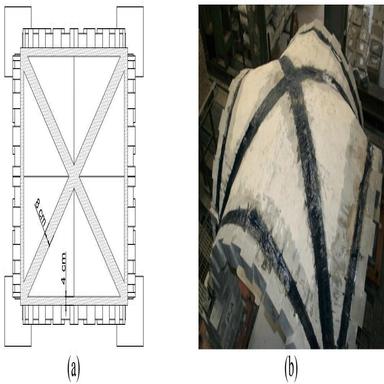
Geometric characteristics of the CFRP sheet reinforcement.